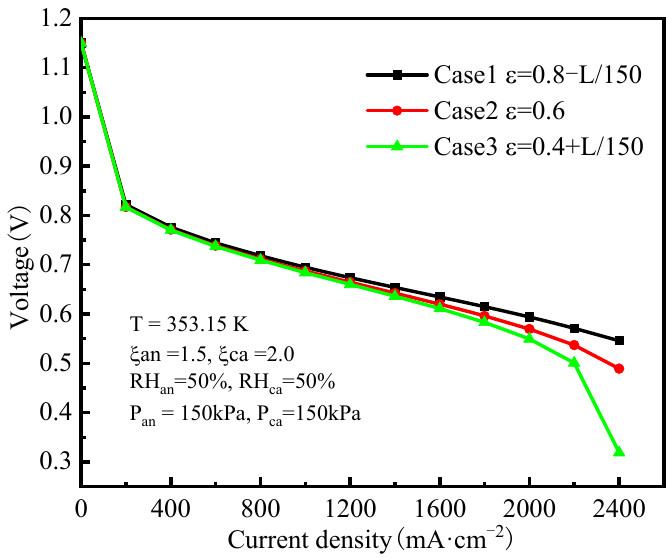
Figure 4. Comparison of the polarization